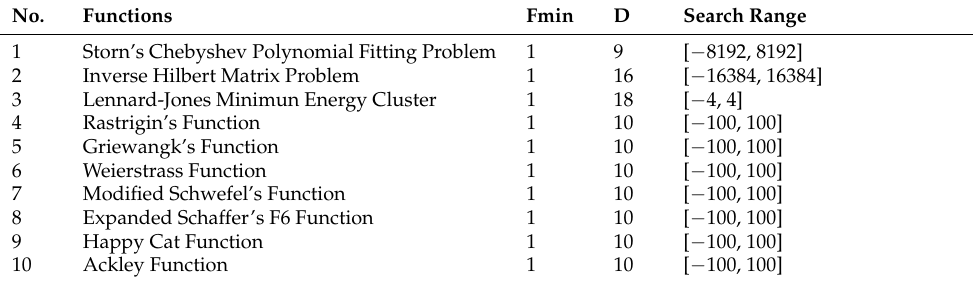
Table 11. CEC2019 benchmark functions.